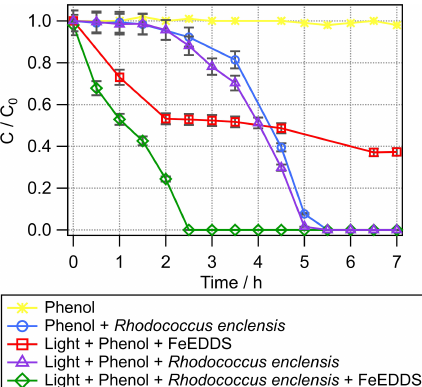
Figure 2. Transformation of phenol with time under different condi- tions. Phenol + light + Fe(EDDS) (red squares), phenol + R. enclen- sis + dark (blue circles), phenol + R. enclensis + light (purple trian- gles), and phenol + R. enclensis + light + Fe(EDDS) (green line). Rhodococcus enclensis cell concentration was 10 9 cellsmL − 1 . Figure 3. Biotransformation of catechol with time by different con-